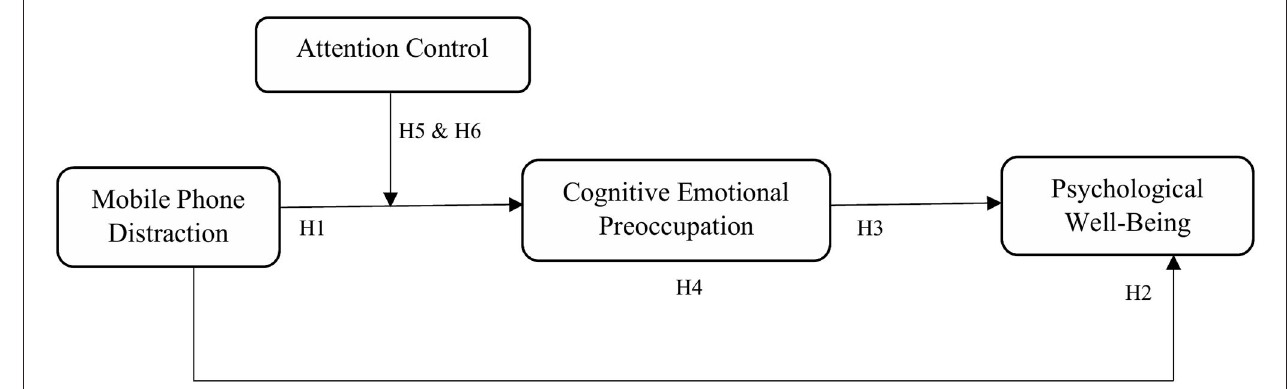
FIGURE 1 | Proposed research model.